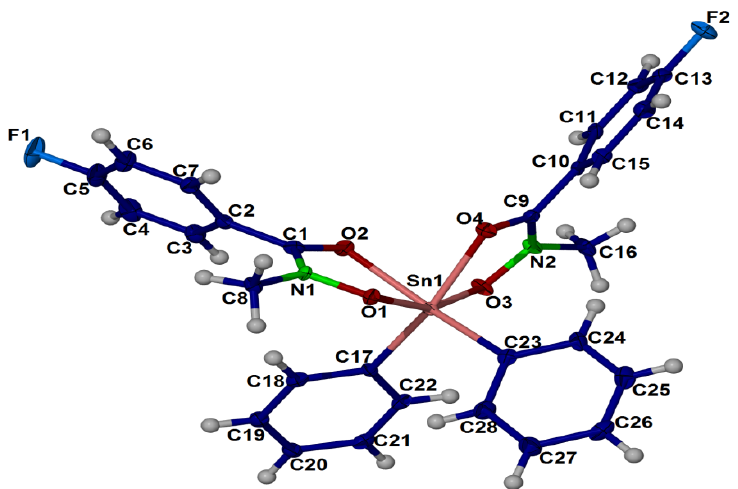
Figure 3. Thermal ellipsoidal plot of C ellipsoids are drawn at the 50% probability level, and H atoms are shown as spheres of arbitrary